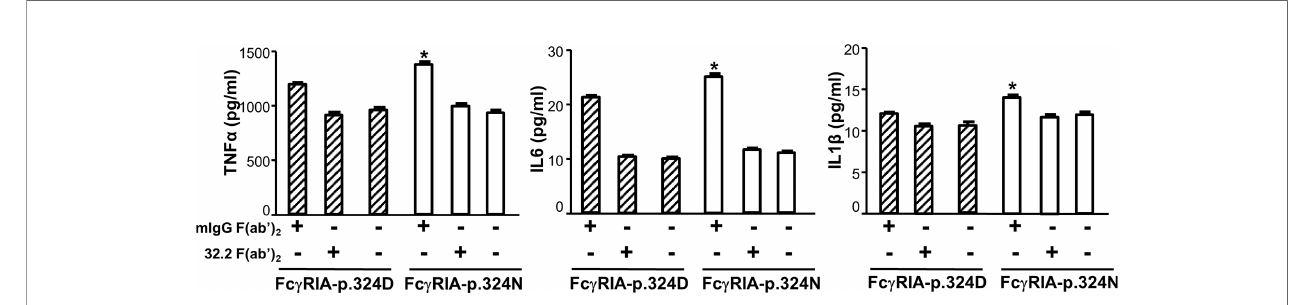
FIGURE 5 | FCGR1A SNV rs1050204 (Fc g RIA-p.D324N) alleles affect CD64-mediated cytokine productions. Fc g RIA-mediated IL-6, IL-1 b , and TNF a productions were signi fi cantly higher in P388 cells with the Fc g RIA-p.324N (rs1050204A) allele than those with the Fc g RIA-p.324D allele (rs1050204G) (*Student ’ s t-test P < 0.01, n = 4). IL-6, IL-1 b , and TNF a productions were not different between the Fc g RIA-p.324D and the Fc g RIA-p.324N alleles in mIgG F(ab ’ ) 2 -stimulated cells or untreated cells ( P